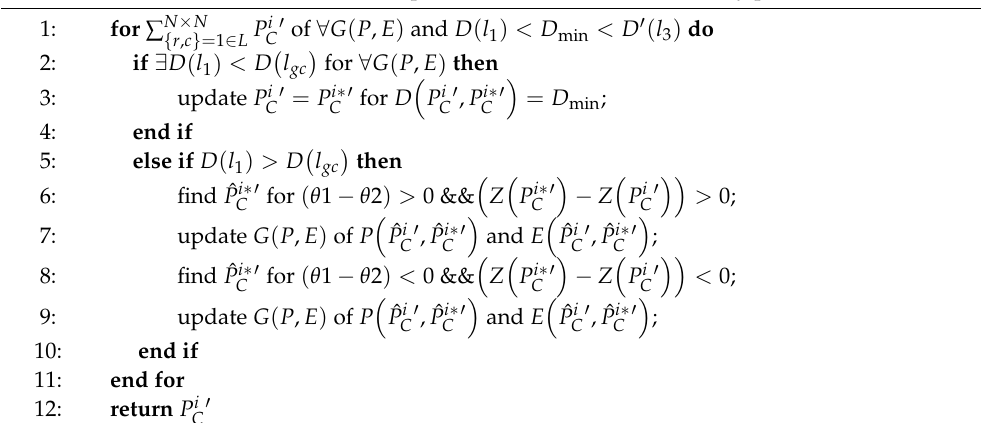
Algorithm 1 The criteria determination process of reachable intervisibility